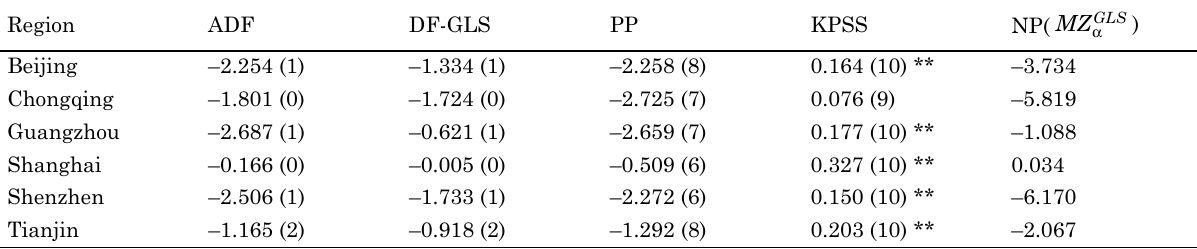
Table 1. Univariate unit root tests results of regional house prices Region